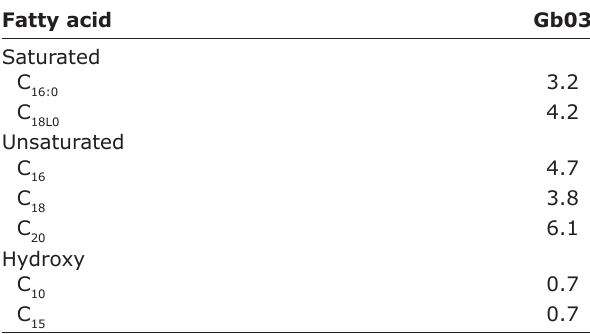
Table-1: Cellular fatty acid content of strain Gb03.